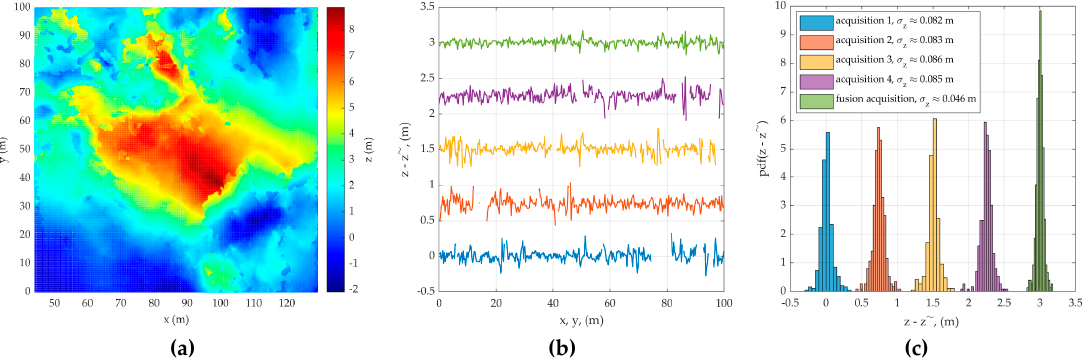
Figure 7. (a) combined DEM; (b) standard deviation of the errors; and (c) its histograms.